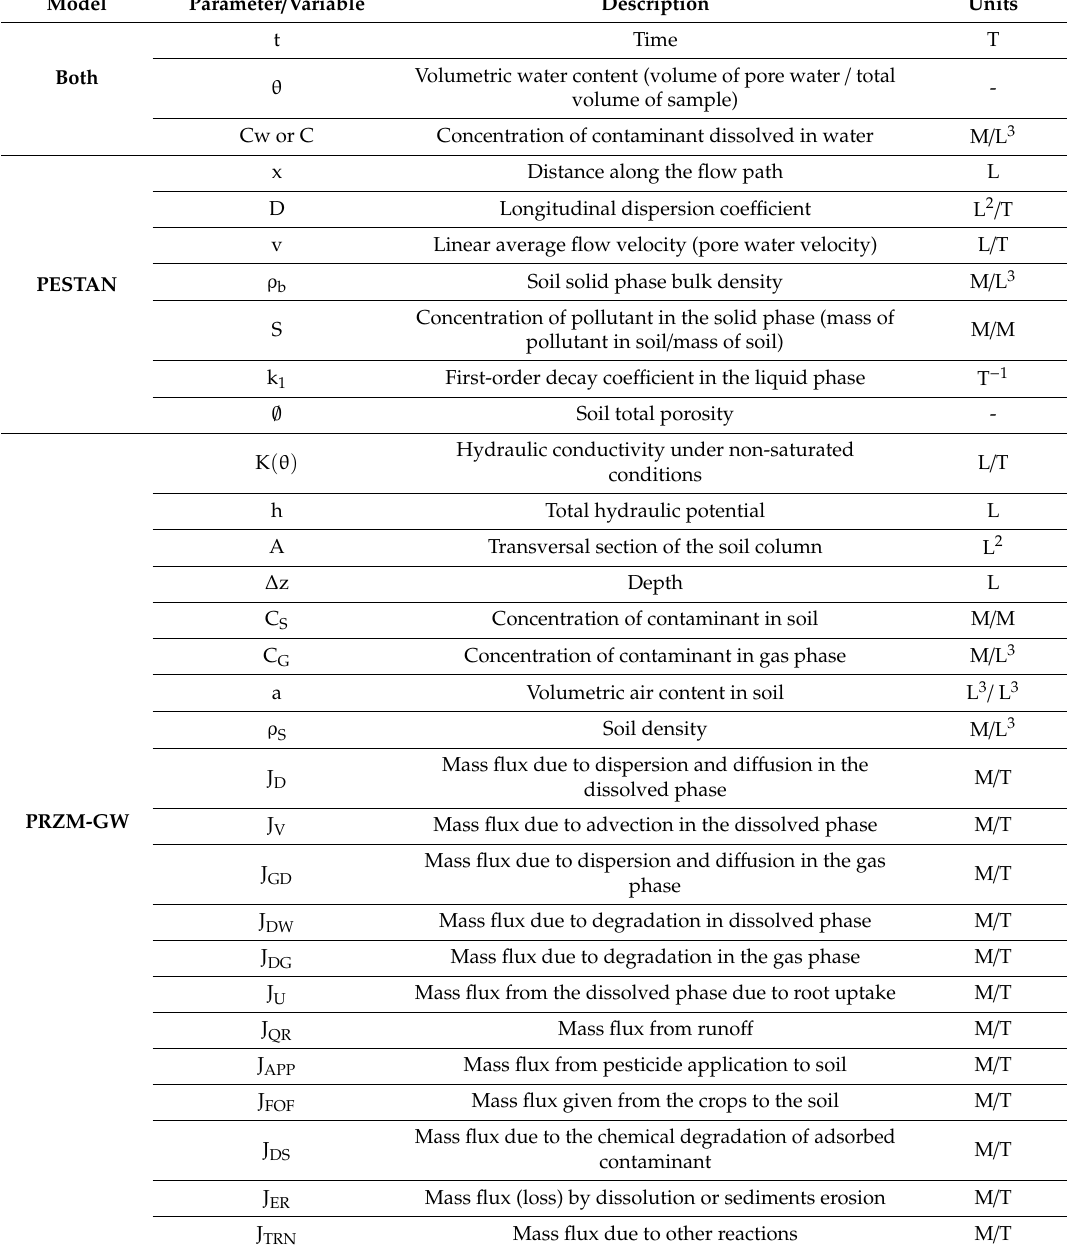
Table 3. PESTAN and PRZM-GW main parameters and